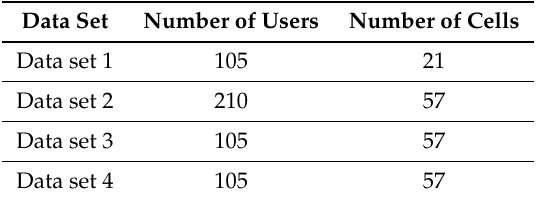
Table 2. Simulation data set